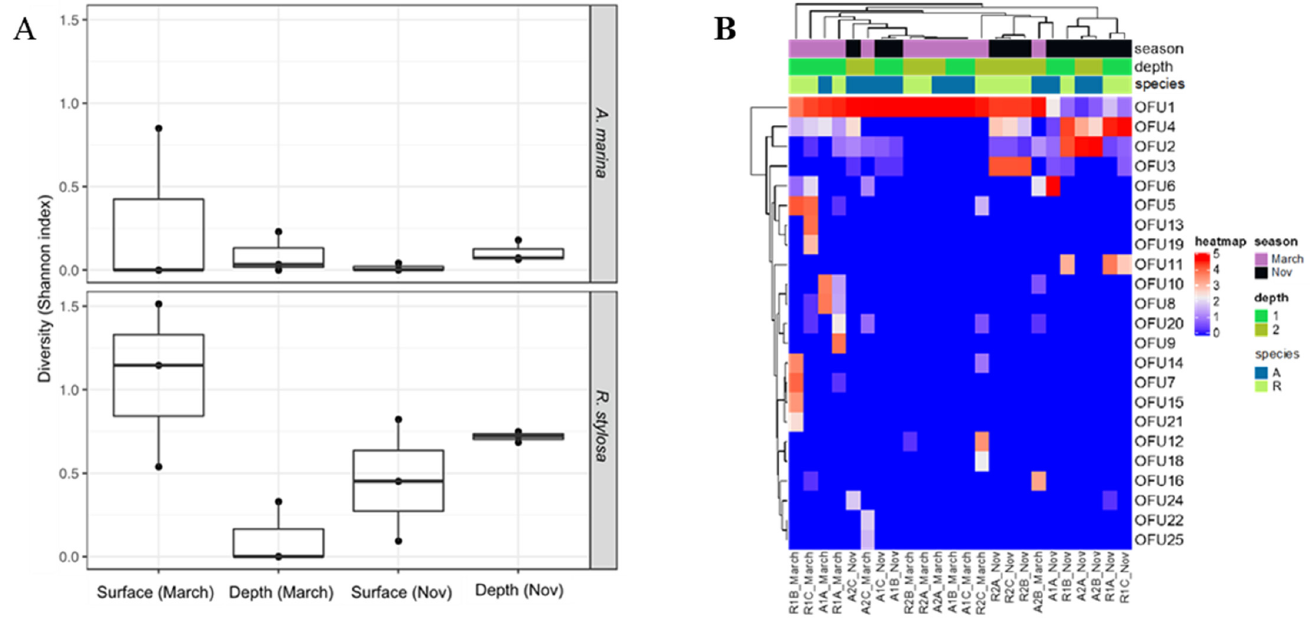
Figure 1. Diversity of expressed genes encoding fungal DyPs in surface and deeper sediments collected beneath two tree species ( Avicennia marina and Rhizophora stylosa ) during the wet (March) and dry (November) seasons. ( A ) Diversity estimated with the Shannon index and ( B ) distribution of the different Operational Functional Units (OFUs).